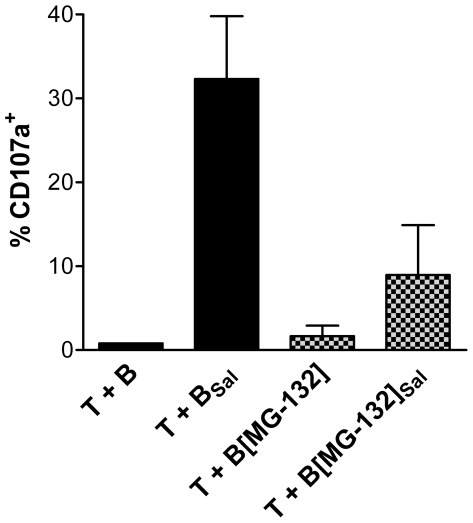
Proteasome inhibition of Salmonella-infected B cells diminishes degranulation of Salmonella-specific CD8+ T cells.CD8+ T cells were activated by Salmonella-infected B cells and after 6 days, Salmonella-specific, proliferating CD8+ T cells were sorted. Next, the sorted CD8+ T cells were reactivated by non-infected B cells (T + B) or Salmonella-infected B cells (T + BSal). Pre-treatment of B cells with proteasome inhibitor MG-132 (20 µM) before reactivation leads to a decrease in degranulation of the Salmonella-specific CD8+ T cells (T + B[MG-132]Sal), as measured by CD107a expression. The data are expressed as mean ± SEM, of two independent experiments of different donors.